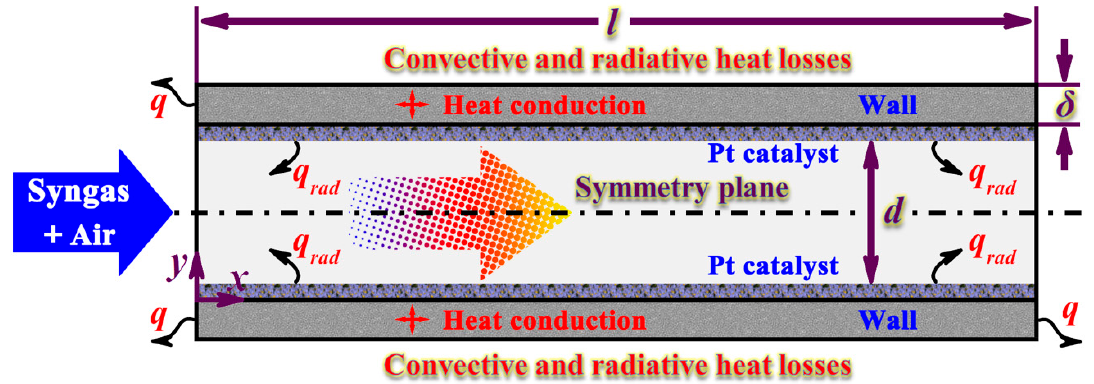
Figure 2. Schematic diagram of the single-channel catalytic microreactor (not to scale for ease of visualization). Symmetry allows the simulation of only half of the system.